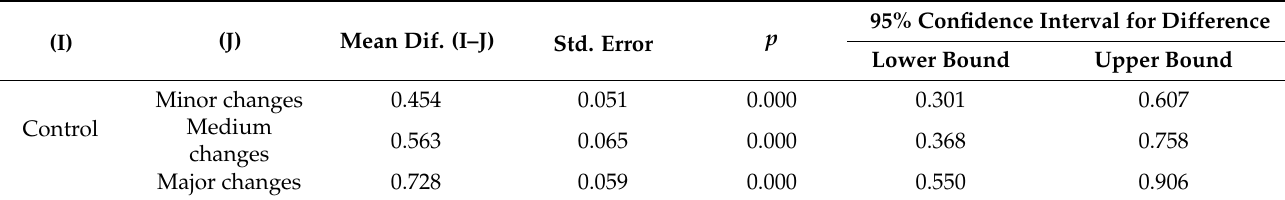
Table 1. Results of ANOVA.